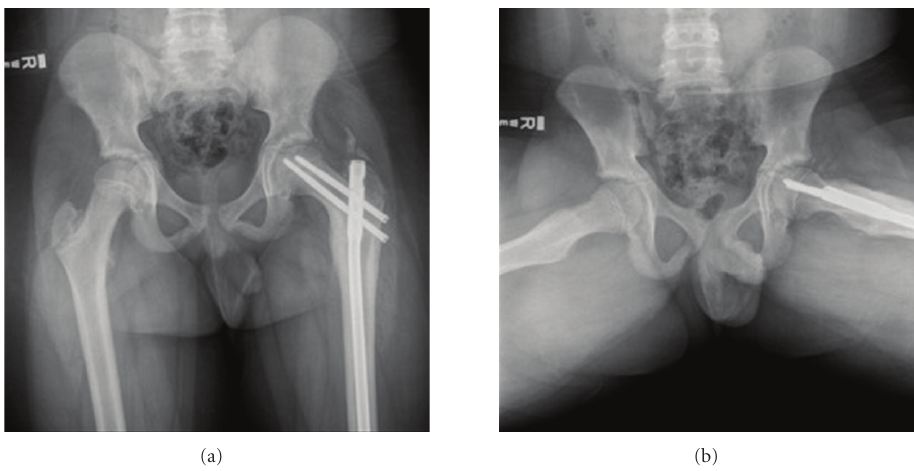
Figure 2: Radiographs 7 months after intramedullary fixation show a healed subtrochanteric fracture and no evidence of progression of the